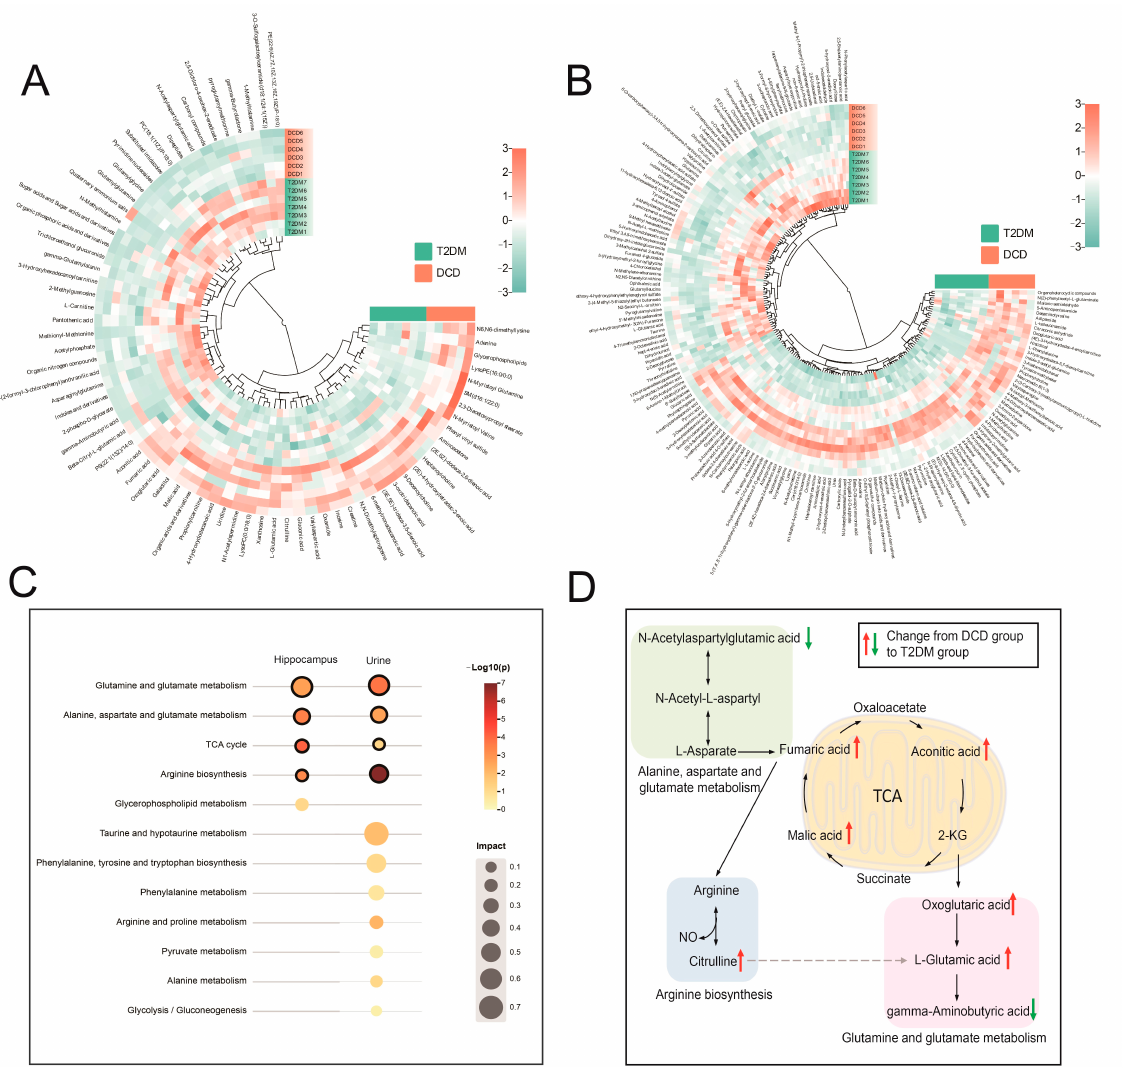
Figure 5. Heatmaps of differential metabolites in hippocampus ( A ) and urine samples ( B ); ( C ) metabolic pathway analysis of differential metabolites in hippocampal tissue and urine; ( D ) changes in the key pathways.